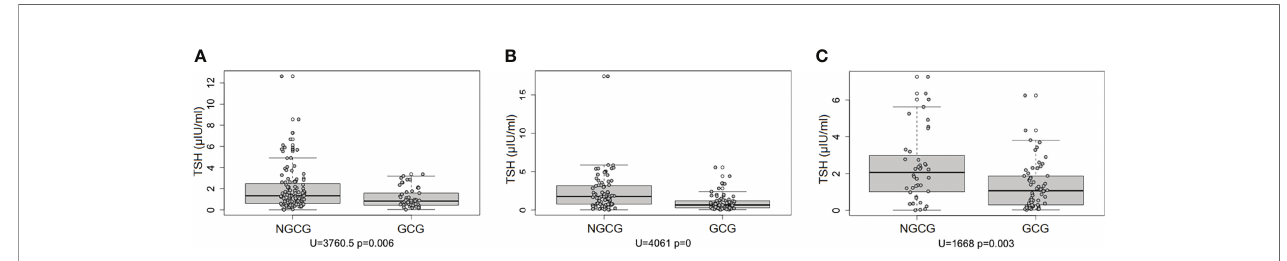
FIGURE 1 | Concentration of TSH over three consecutive time points among patients not treated with glucocorticoids (NGCG) and treated with glucocorticoids (GCG). (A) time point #1; (B) time point #2; (C) time